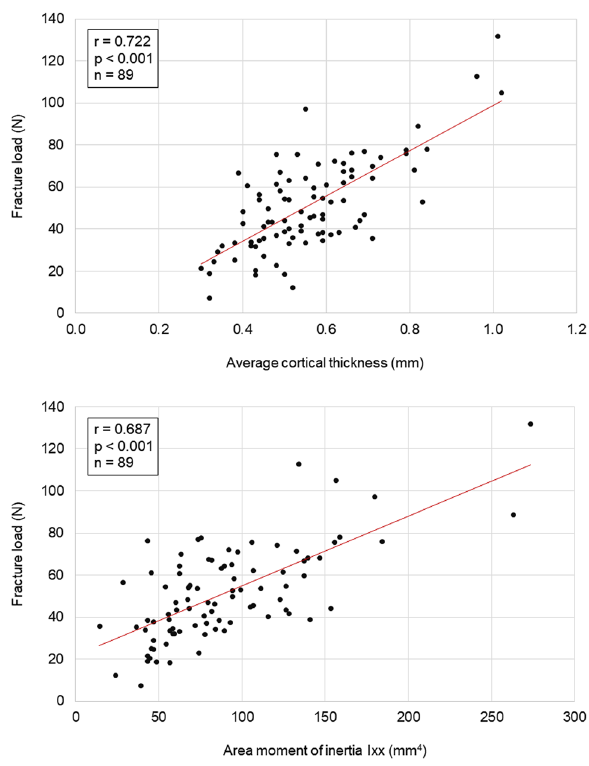
Figure 3. Scatter diagrams illustrating the effects of cortical thickness and area moment of inertia around the longitudinal axis of the rib cross-sectional area (xx) on fracture load. Trend lines are depicted in